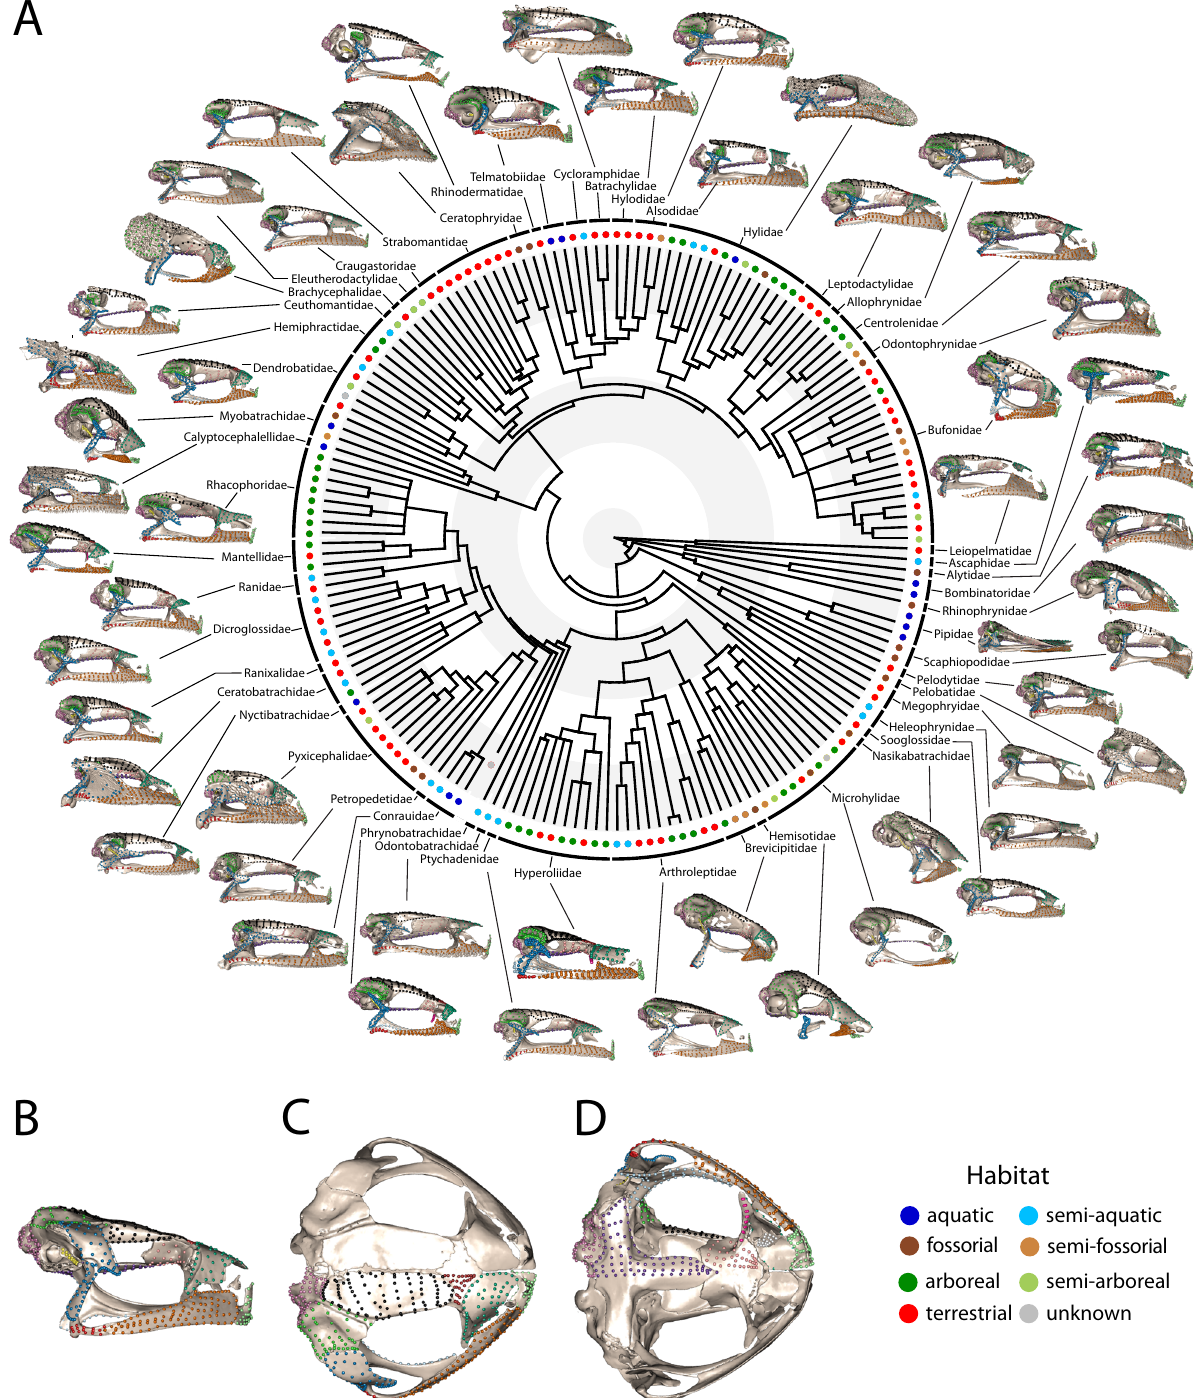
Fig. 1 Cranial shape diversity across Anura. A De fi ned cranial regions displayed on one anuran skull from every family across the phylogeny (lateral aspect, skulls not to scale). Phylogeny for the 173 species in this study modi fi ed from Jetz and Pyron 113 with the addition of Thaumastosaurus gezei . Branch lengths are scaled to time, with alternate shaded bands indicating periods of 50 million years (outer extreme at Recent). For details on specimens visualised here, see Supplementary Data 1. Landmarks and semilandmarks in B lateral, C dorsal and D ventral views, shown on Adenomus kelaartii (FMNH: Amphibians and Reptiles:1580). Points are coloured according to the 15 regions de fi ned in this study. Regions are as follows: Occ (light purple) occipital region, FP (black) frontoparietal, Qj (red) quadratojugal, Max (orange) maxilla, Na (green) nasal, Neo (hot pink) Neopalatine, Otic (lime green) otic region, Pm (pale green) premaxilla, PS (purple) parasphenoid, Pt (light blue) pterygoid, SphD (brown) sphenethmoid (dorsal surface), SphV (light pink) sphenethmoid (ventral surface), Sq (blue) squamosal, St (yellow) stapes, Vo (grey)